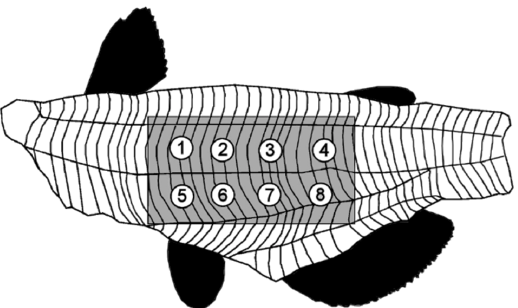
Figure 1. Positions 1 − 8 on fillet used for texture profile analysis. Shaded area was removed from the fillet before cooking [26].